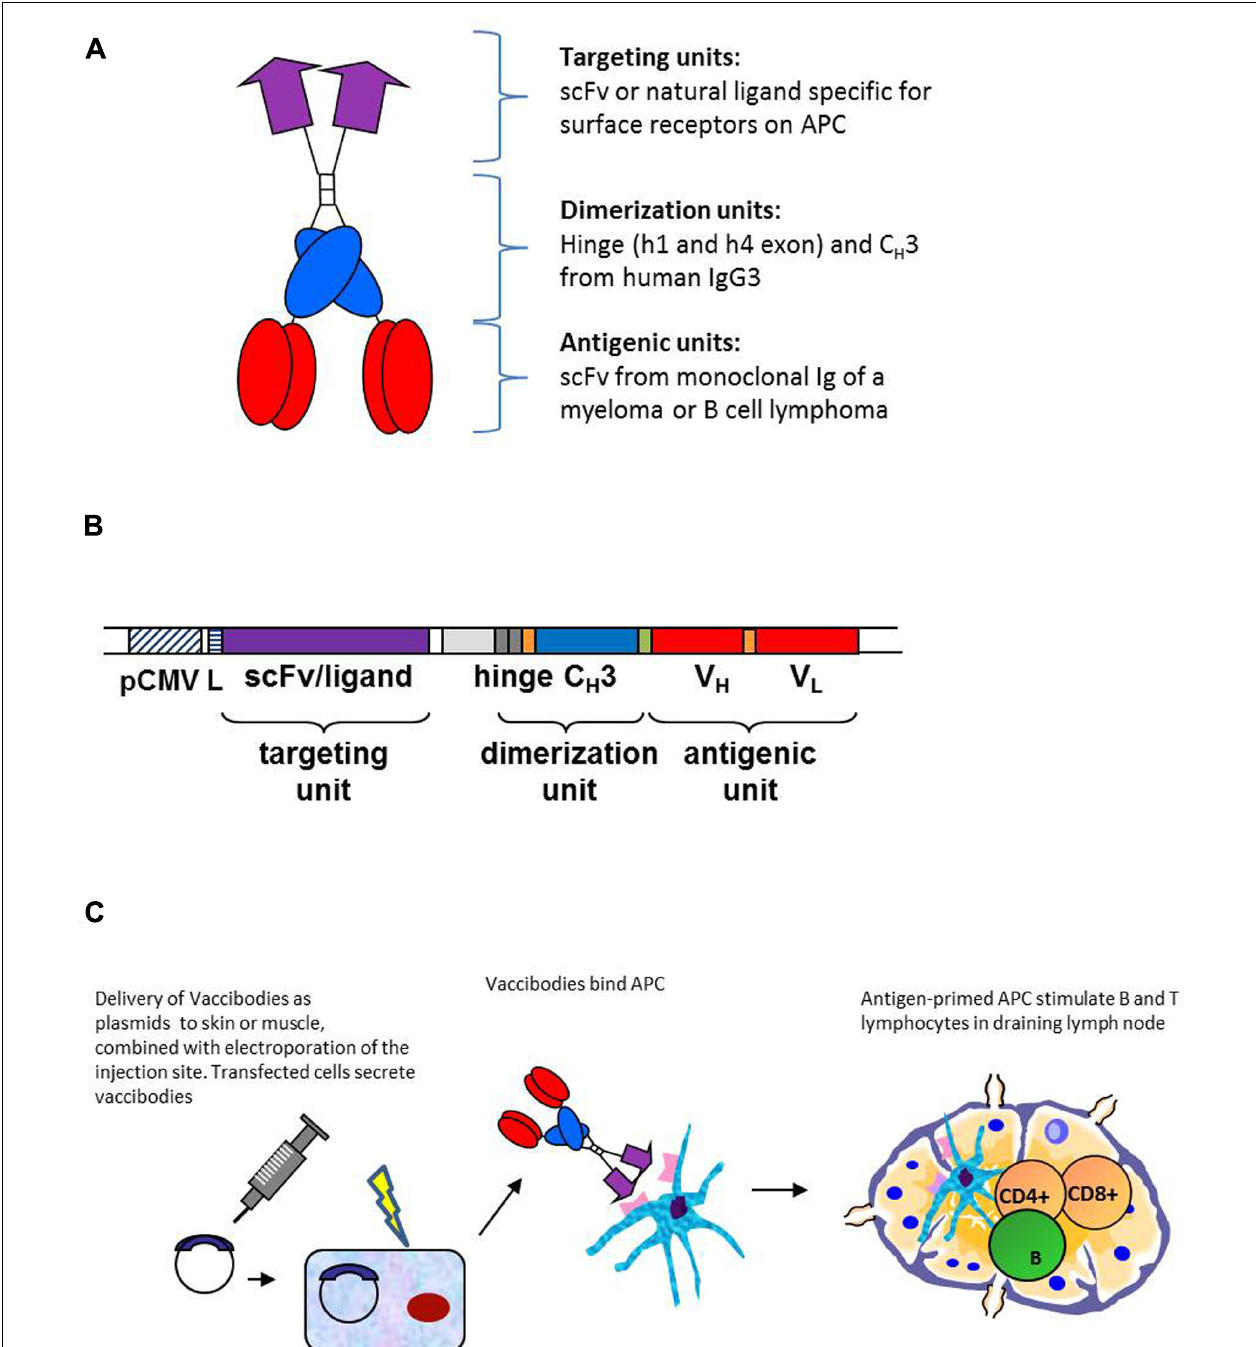
dimerization unit, composed of h1 and h4 hinge exons and the C H 3 exon of human IgG3 ( blue ), is linked to the antigenic unit ( red ) and inserted together in the C cassette of pLNOH2.The (G 4 S) 3 linkers ( orange ) and the GLSGL linker ( green ) are indicated.The gene is expressed from a CMV promoter (hatched) and a leader sequence ( striated ) of the pLNOH2 vector ( uncolored ). Upstream of h1 is an intronic sequence ( light gray ) Reproduced